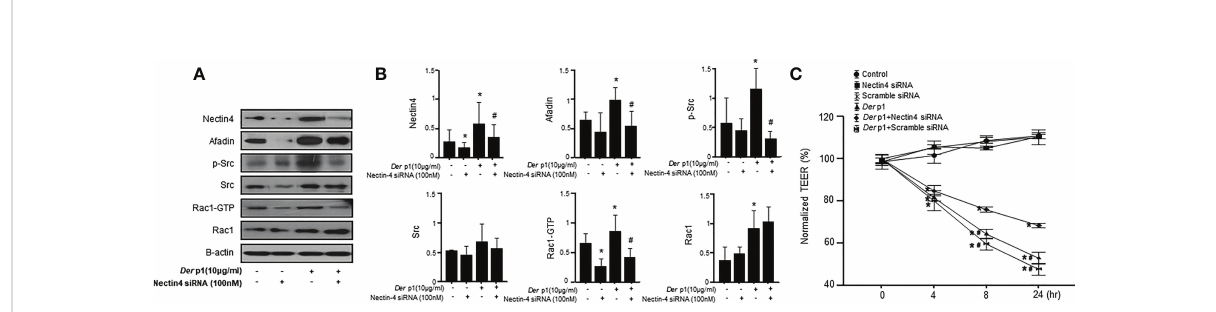
FIGURE 4 The knockdown of Nectin4 alters the expression of Afadin and the Src/Rac1 pathway. (A) Nectin4 knockdown alters the expression of Afadin and the Src/Rac1 pathway in NHBE cells treated with Der p1. (B) The values were normalized to those of b -actin and are expressed as the means ± SDs. (C) Time-dependent increases in TEER in NHBE cells treated with Der p1 and decreases in NHBE cells treated with Der p1 and Nectin4 siRNA. The results are representative of at least 3 independent experiments. *p<0.05 compared to the